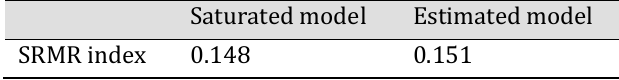
Table 7. SRMR validation of empirical research